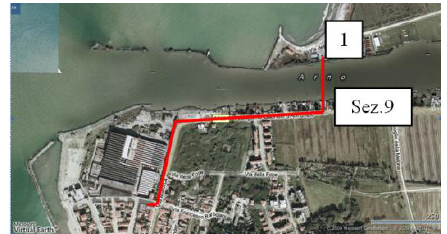
Figure 11. Connection of the wells to the national leveling